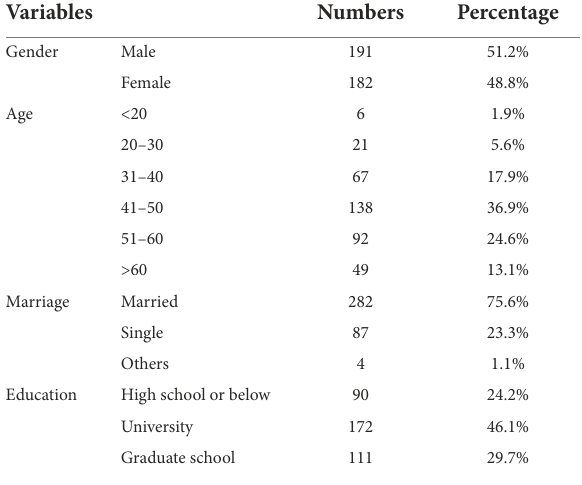
TABLE 2 The sample description (total n = 373). TABLE 3 Analysis of news consumption and environmental attitudes toward the use of circular